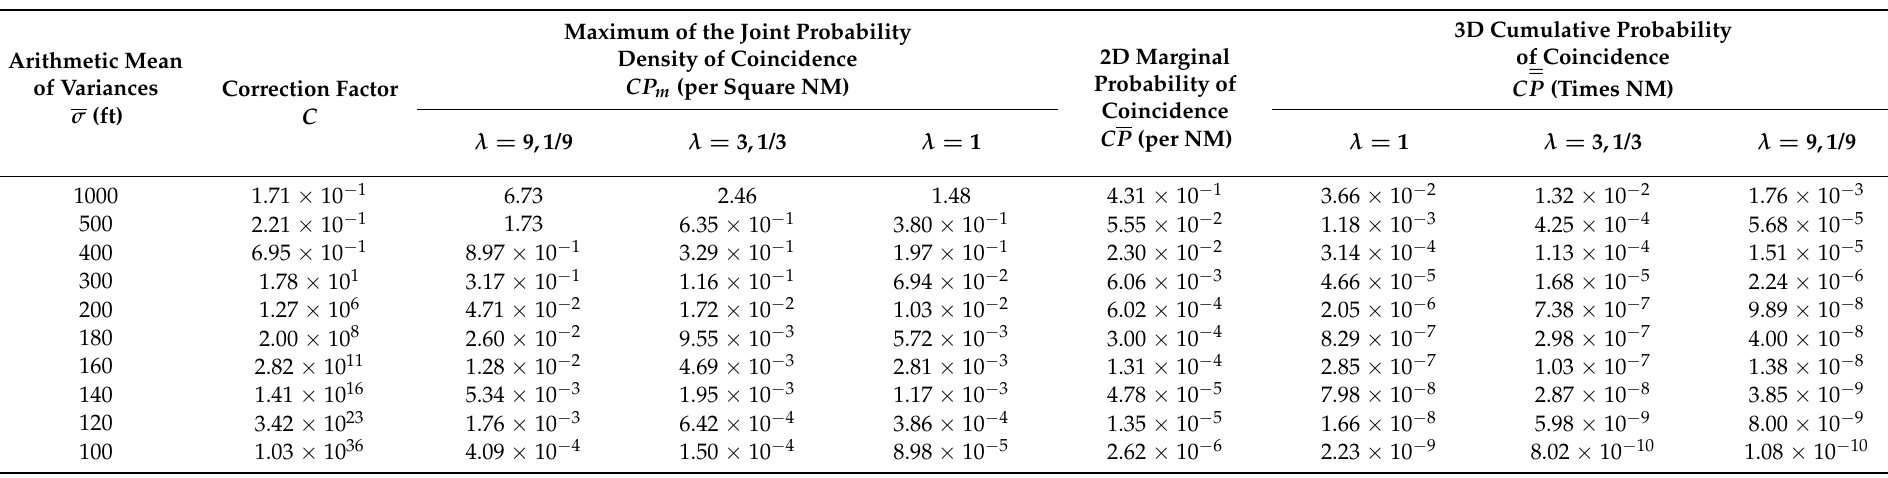
Table 5. Table 2 was calculated for a Gaussian probability distribution (59) and is recalculated for a generalized exponential probability distribution (57), using the correction factor (65).